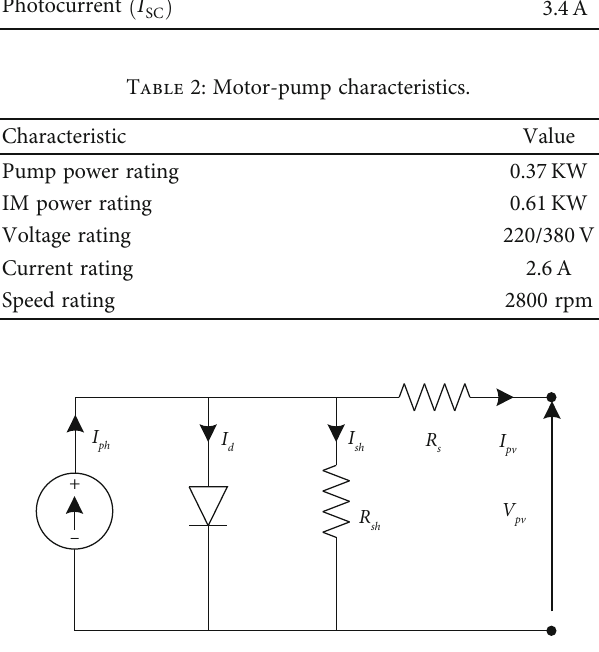
Figure 2: Solar cell equivalent